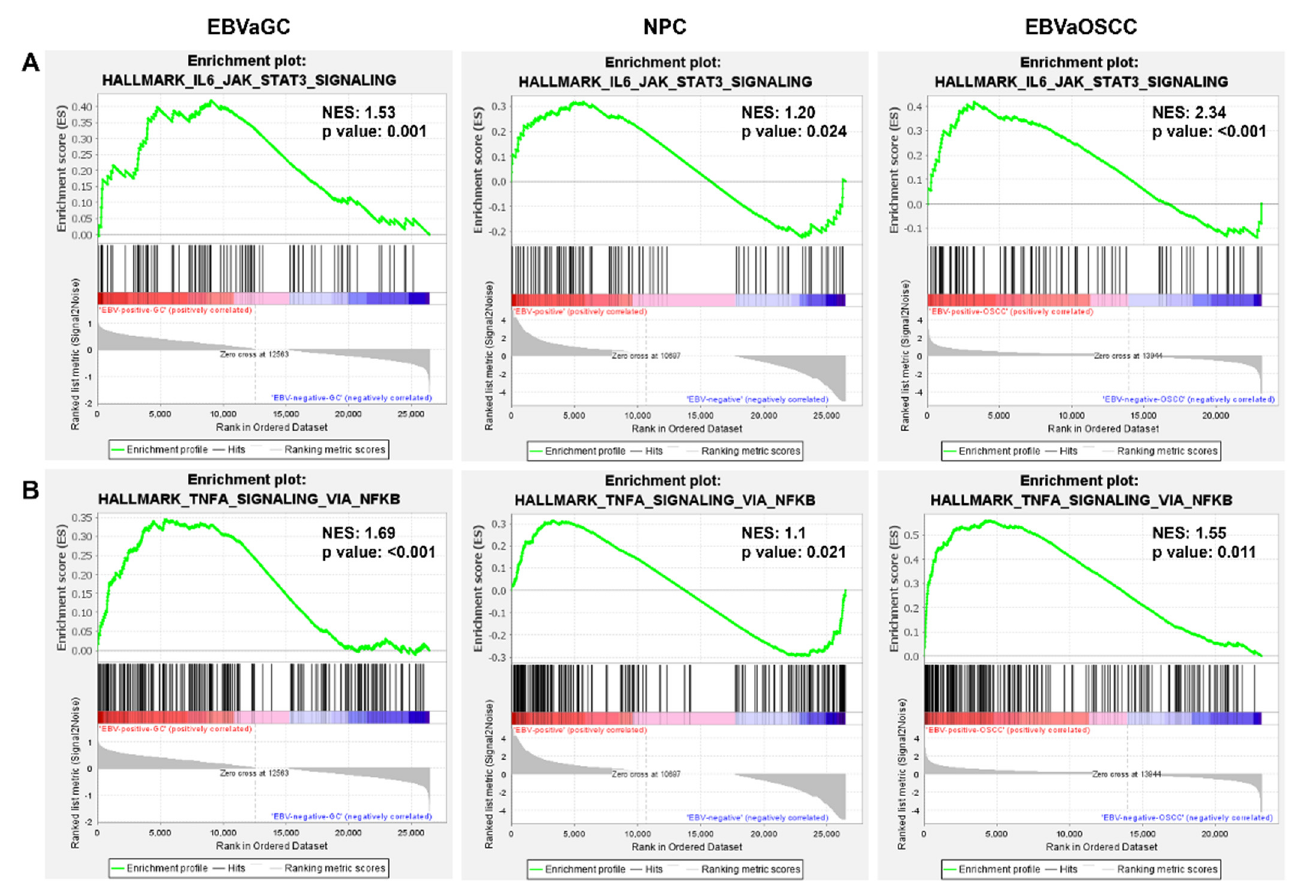
Figure 6. Identification of common hallmarks in EBV ‐ associated epithelial cancers. Gene set enrichment analysis (GSEA) of genes in EBV ‐ infected cells compared with non ‐ EBV ‐ infected cells. GSEA identified the IL6/JAK/STAT3 ( A ) and TNF ‐α /NF ‐κ B ( B ) signaling pathways as a common hallmark in EBVaOSCC, NPC, and EBVaGC. The green line indicates enrichment profiles. The vertical black bar and the vertical grey bar indicate hits and ranking metric scores, respectively.